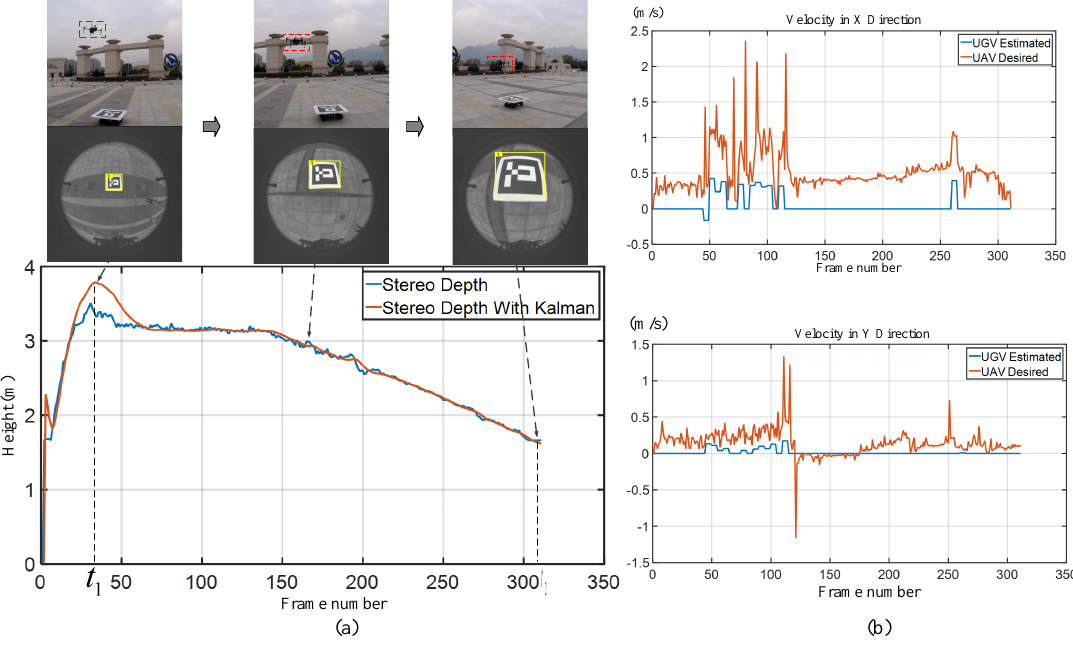
Figure 15. The results of the autonomous landing system built with DJI M100, including ( a ) the flight altitude changes of the UAV; ( b ) the velocity changes in the X and Y directions of the UGV and